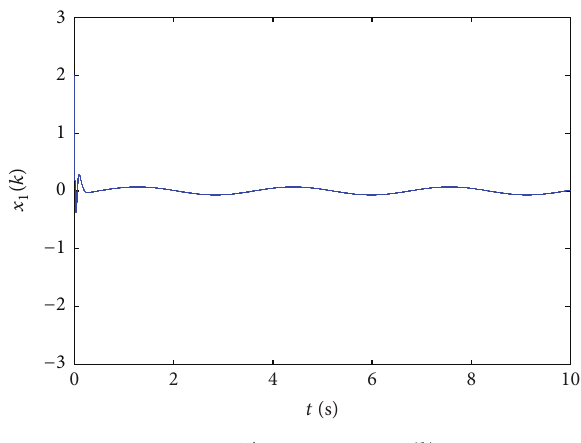
Figure 8: The system state 𝑥 1 (𝑘)